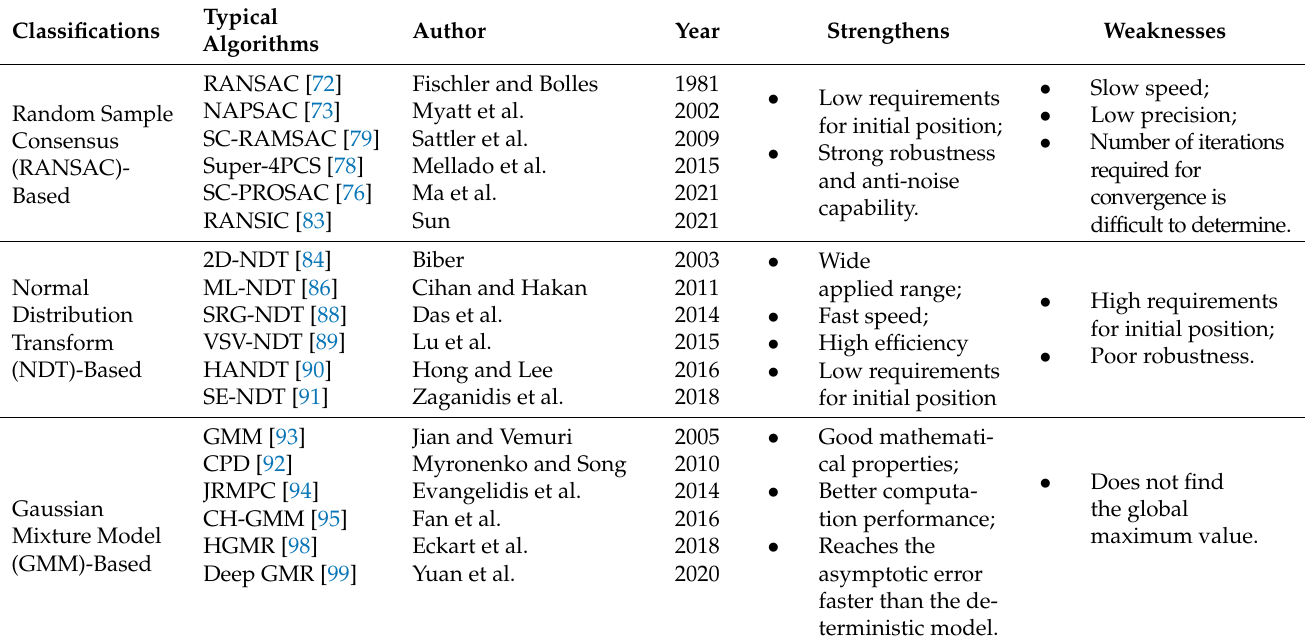
Table 2. Summary of registration algorithms based on probability stochastic distribution